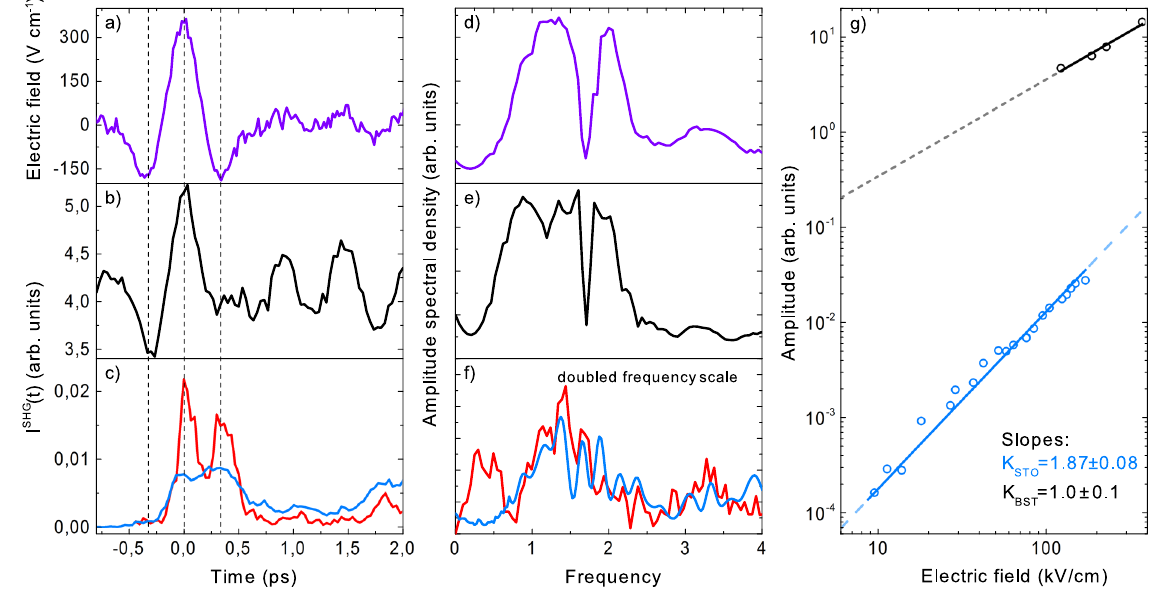
Figure 2. THz-induced dynamics of nonlinear-optical response of the crystals. ( a ) Time trace of the electric field of the THz pump pulse; intensities of the SHG-signal: ( b ) for BST, ( c ) for STO (red line) and Si (black line); ( d – f ) Fourier transform spectra of the time traces shown in panels ( a – c ), respectively (( f ) plotted in doubled frequency scale); ( g ) dependence of the SHG intensity on the THz field (logarithmic scale) for BST (top line) and STO (bottom